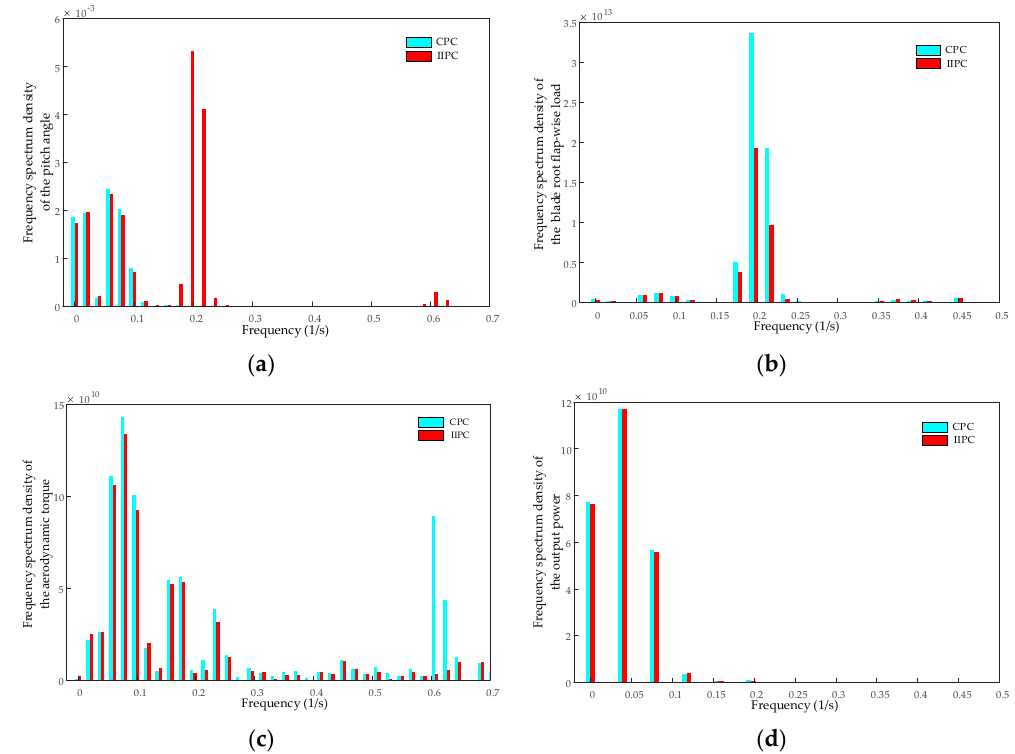
Figure 15. Simulation results of different data of wind turbine under turbulent wind and random wave: ( a ) Frequency spectrum density of the pitch angle; ( b ) Frequency spectrum density of the blade root flap-wise load; ( c ) Frequency spectrum density of the aerodynamic torque; ( d ) Frequency spectrum density of the output power.